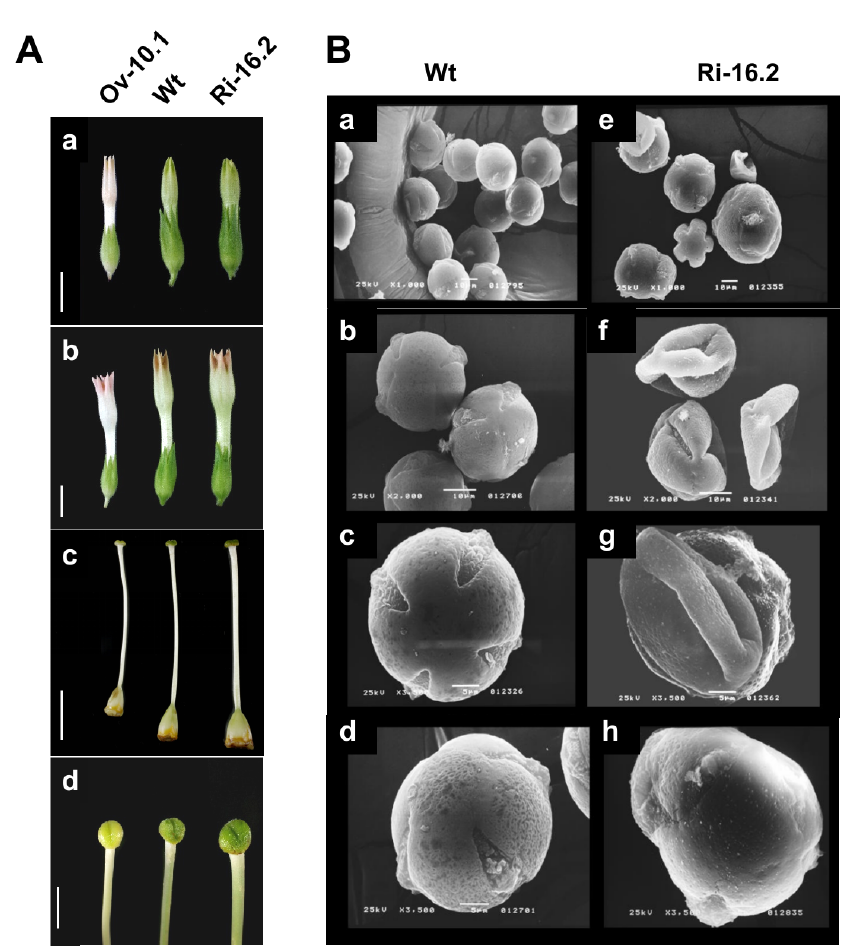
Figure 4. Morphological differences between wild type and transgenic plants. ( A ) Comparison of the phenotypes of transgenic and wild type plants. In all images, wild type plants (WT) are localized between transgenic plants PAEOv-10.1 and PAERi-16.2. ( a ) floral bud at stage 7. Bar = 1 cm; ( b ) floral bud at stage 10. Bar = 1 cm; ( c ) pistils of transgenic plants and wild type at stage 12; ( d ) Stigmas of wild type and transgenic plants. Bar = 3 mm. ( B ) Scanning electron microscopy of pollen grains of wild type ( a – d ) and PAERi-16.2 ( e – h ) plants. The pollen grains of PAERi-16.2 show irregular walls and apertures compared to the wild